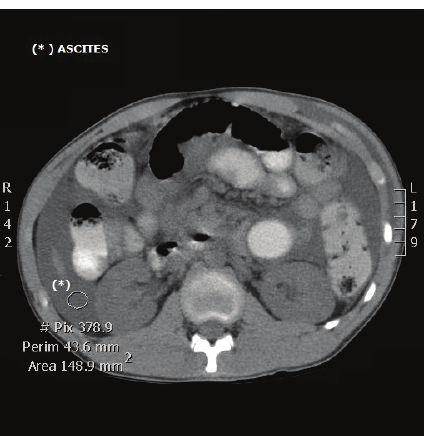
Figure 1: Axial CT slice demonstrating free fluid in the peritoneal cavity.Theslidewasmadeatthelevelofthekidneysthatdonotshow hydronephrosis.